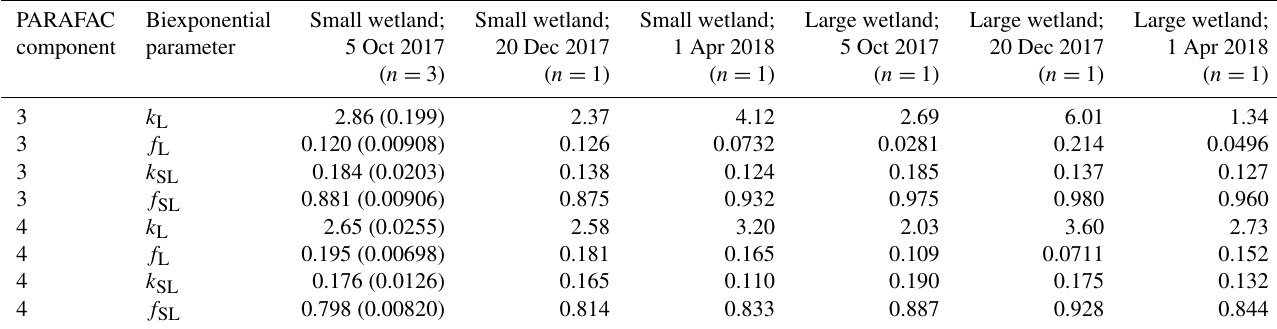
Table A3. Fitted biexponential model parameters (Eq. 3) for wetland DOM samples. f is unitless, and k is m 2 [molphotons] − 1 . Where n> 1, means are shown with standard deviations in parentheses. p values of biexponential model fits are all below 1 × 10 − 6 . Model parameters for every individual trial can be found in the associated data set (Armstrong,